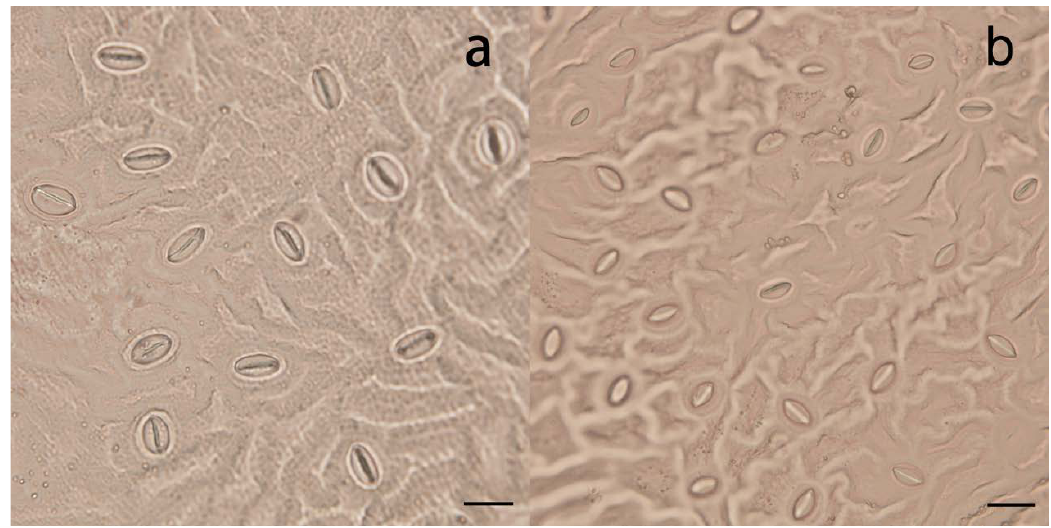
Figure 3. Stomata size and density in Eucalyptus urophylla (scale bar = 20 μm). ( a ) Triploid plant. ( b ) Diploid plant. Table 6. Descriptive statistics (mean values ± SD) of ten quantitative traits measured from the top mature leaf of Eucalyptus urophylla at 6 months old .